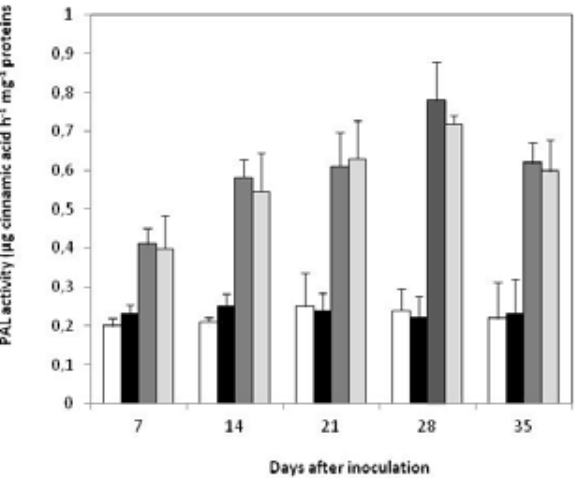
Figure 3. Levels of phenylalanine ammonia-lyase (PAL) in chickpea roots inoculated with Rhizobium strain PchAZM and infested by Orabanche foetida . Activities were meas- ured at 7, 14, 21, 28 and 35 d after inoculation with rhizo- bia and infection with O. foetida (light grey). Experimental controls were performed with healthy chickpeas ( ) singly inoculated (dark gray) or singly infected with O. foetida ( ).